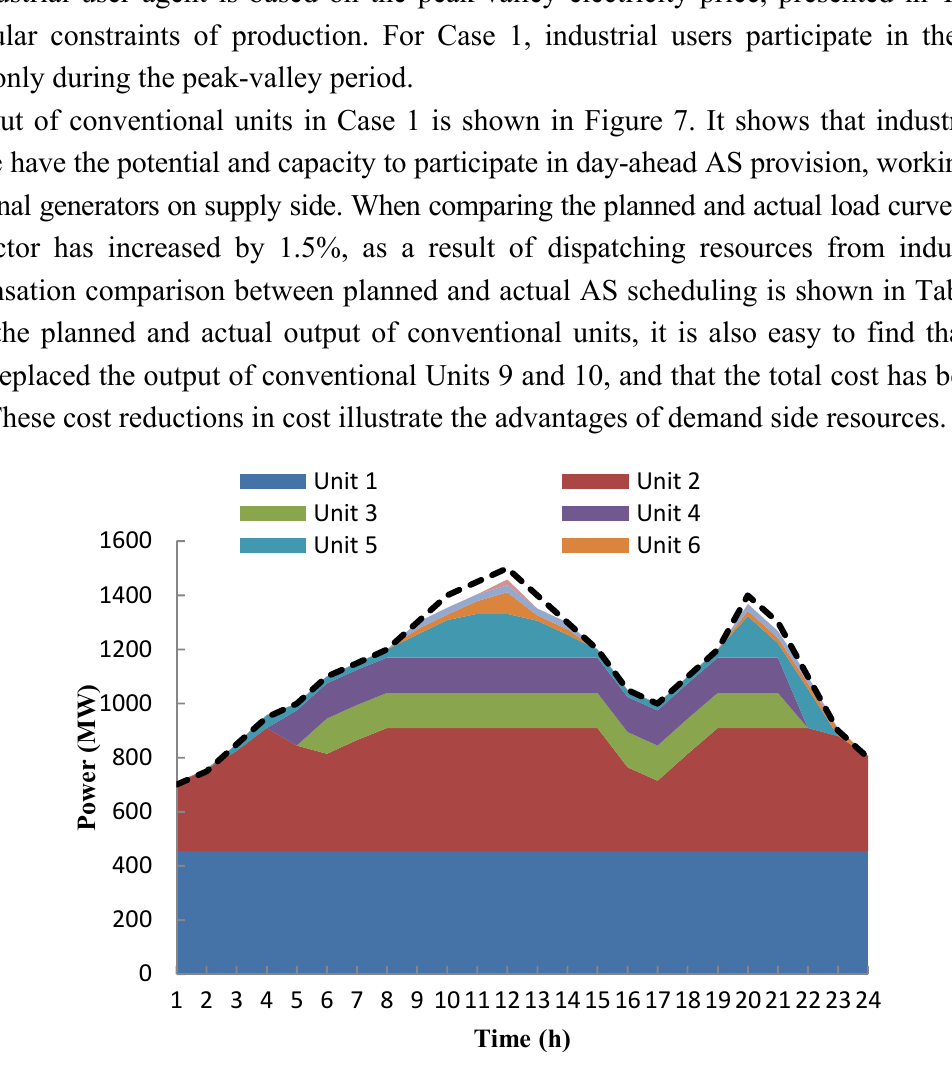
Figure 7. Output of conventional units when industrial users participate in day-ahead AS scheduling. Table 8. Compensation comparison between planned and actual AS